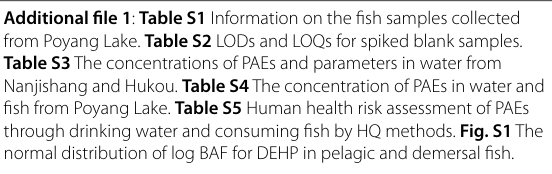
Additional file 1 : Table S1 Information on the fish samples collected from Poyang Lake. Table S2 LODs and LOQs for spiked blank samples. Table S3 The concentrations of PAEs and parameters in water from Nanjishang and Hukou. Table S4 The concentration of PAEs in water and fish from Poyang Lake. Table S5 Human health risk assessment of PAEs through drinking water and consuming fish by HQ methods. Fig. S1 The normal distribution of log BAF for DEHP in pelagic and demersal fish.